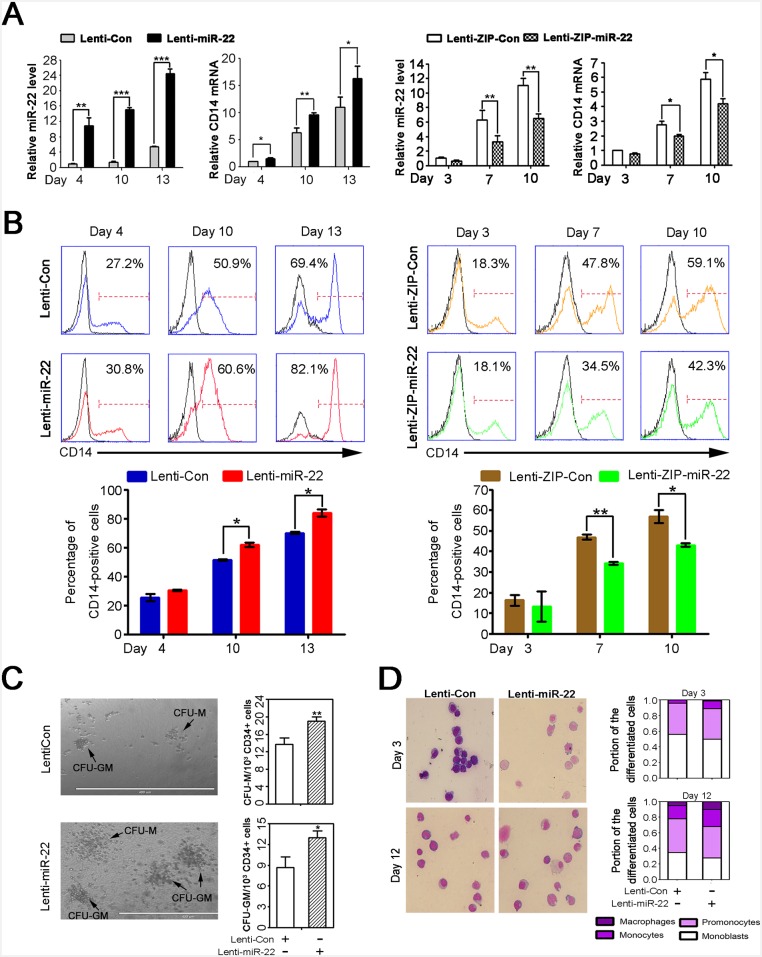
miR-22 promotes monocyte/macrophage differentiation of CD34+ HSPCs.Two sets of the experiments on CD34+ HSPCs were performed. For each, CD34+ cells were purified from human UCB derived from three or four healthy donors. The CD34+ HSPCs were infected with Lenti-miR-22 or Lenti-ZIP-miR-22 or a relative control. After infection for 24 hours, the cells were cultured in a monocyte/macrophage induction medium. A. The overexpression and inhibition of miR-22 increased and decreased expression of the monocyte/macrophage differentiation marker CD14 respectively. To detect miR-22 and CD14 mRNA levels, qRT-PCR was performed at the indicated induction time. Error bars represent SD (n = 2). (*P<0.05, **P<0.01, ***P<0.001, Student’s t-test). B. Flow cytometry analysis was performed to examine the percentage of CD14-positive cells in the infected cells. A representative experiment is presented in the upper columns, and a statistical analysis is shown in the lower columns. The black-line curve represents the unstained cells. Error bars represent SD (n = 2). (*P<0.05, **P<0.01, Student’s t test). C. Colony-forming assays. After infection of the CD34+ HSPCs with Lenti-miR-22 or Lenti-Con, the cells were exposed to a complete methylcellulose medium without EPO. Colonies were observed at Day 12 under 400 X magnification (left), and the number of CFU-M and CFU-GM colonies were counted (right). A representative experiment is presented (n = 2). D. May–Grünwald Giemsa staining and the determination of percentages of cells at various differentiation stages. In total, 100 cells were counted for each sample. A representative experiment is presented (n = 2).